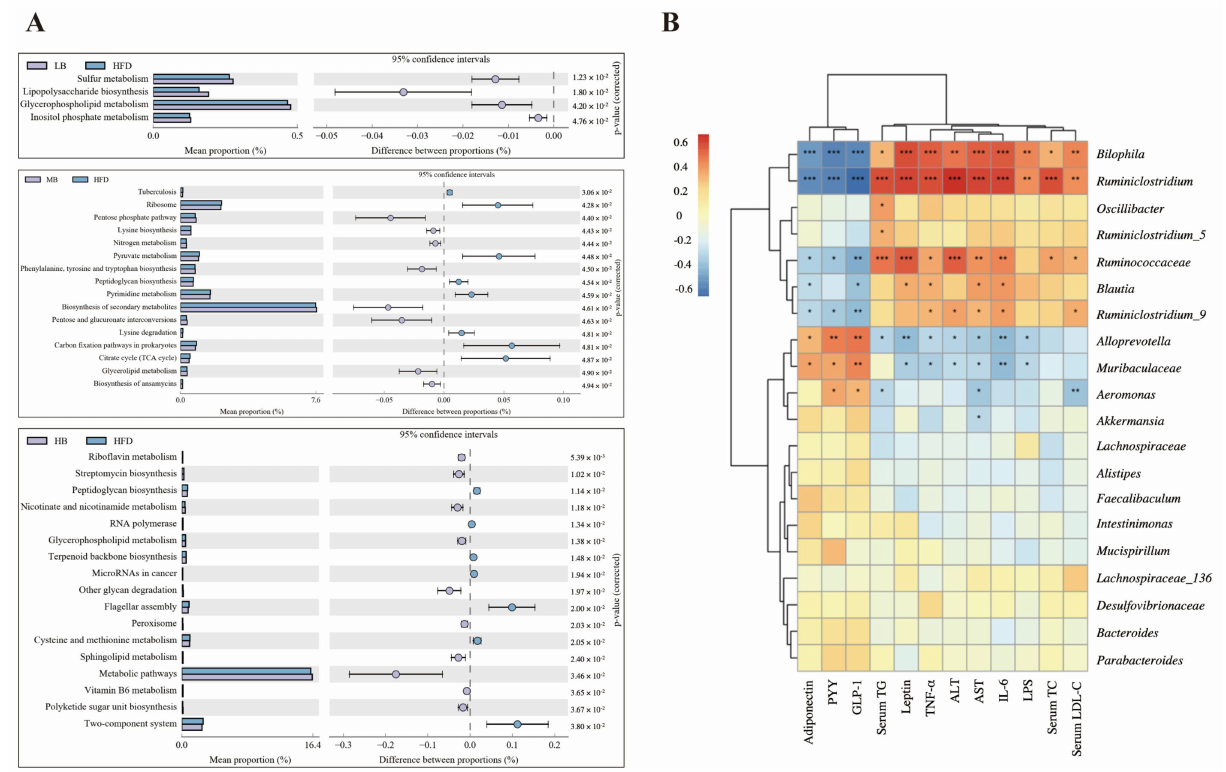
Figure 7. Predictive function profiling of the gut microbiome and correlation analysis. ( A ) PICRUSt analysis based on 16S rRNA sequencing and KEGG database. ( B ) Spearman’s correlation heatmap between gut microbiota and metabolic-disorder-related indices. * p < 0.05, ** p < 0.01, *** p <